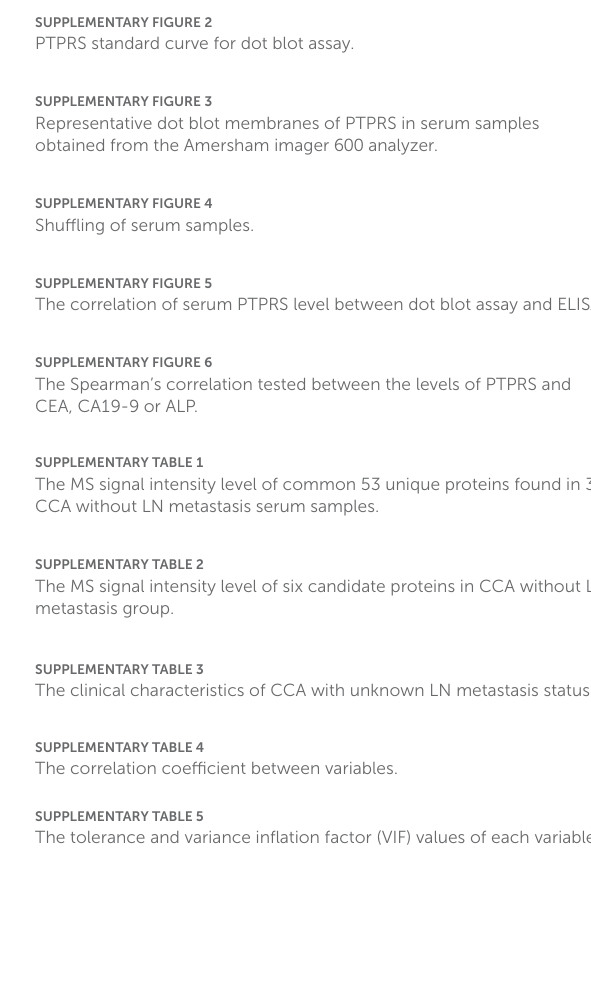
SUPPLEMENTARYFIGURE1 The expression of PTPRS in serum samples were investigated by western blot. SUPPLEMENTARYFIGURE2 PTPRS standard curve for dot blot assay.